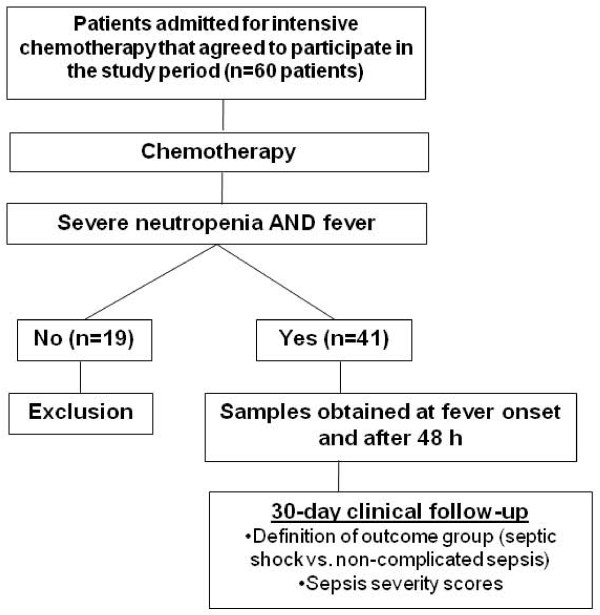
Study flowchart.